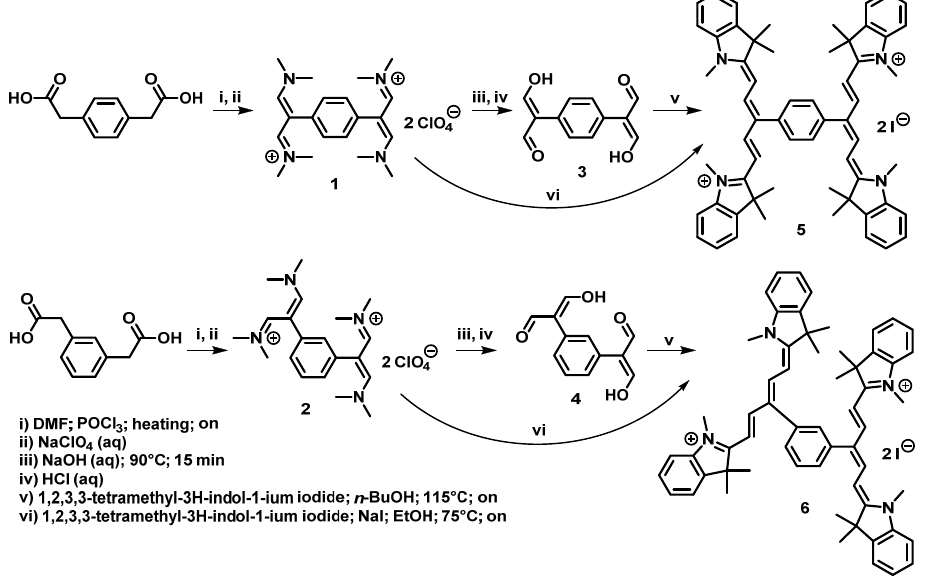
Figure 1. Synthesis of Bis ‐ PMSs 5 and 6 overnight (on).